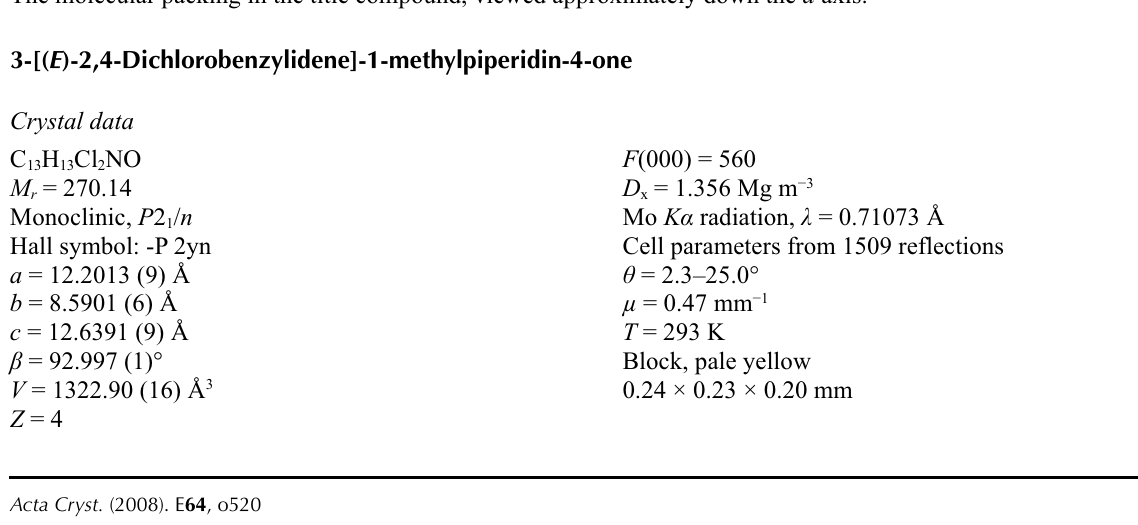
The molecular packing in the title compound, viewed approximately down the a